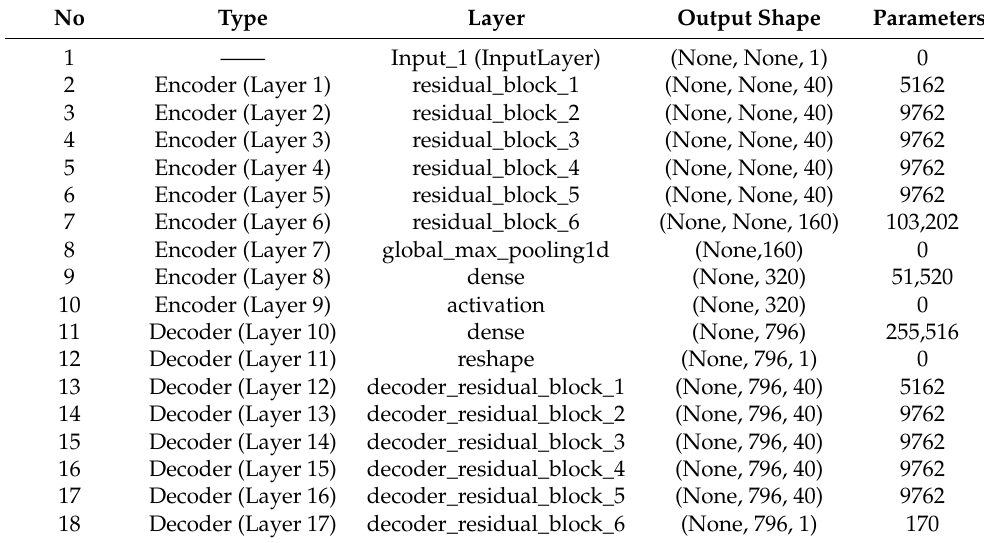
Table 2. TCN encoder–decoder network structure and parameter